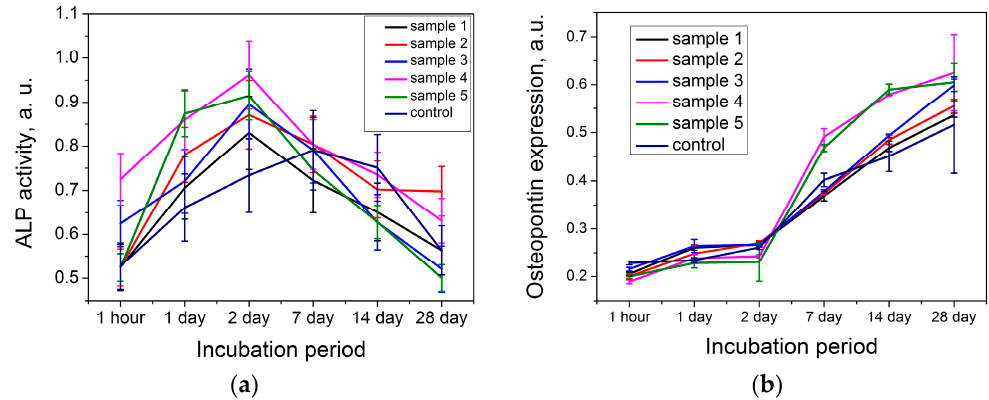
Figure 2. Assessment of expression of osteogenic markers: alkaline phosphatase activity ( a ) and osteopontin expression ( b ) of osteoblast-like cells incubated on the samples 1–5 surface as compared with the control sample.